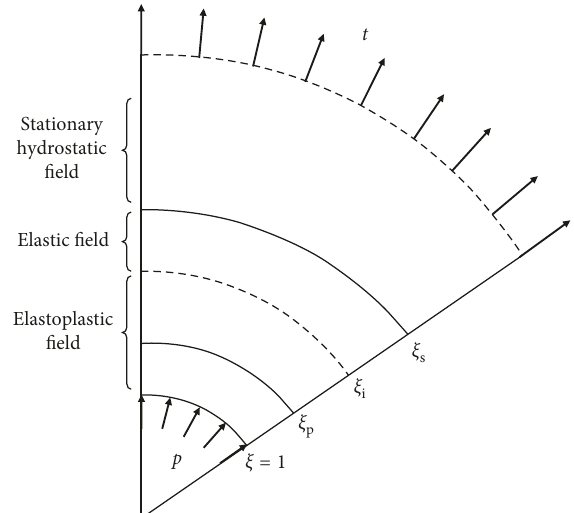
Figure 4: Scheme of the self-similar field induced by expansion of a spherical cavity in an unbounded medium, in the presence of an elastoplastic shock wave at ξ � ξ p